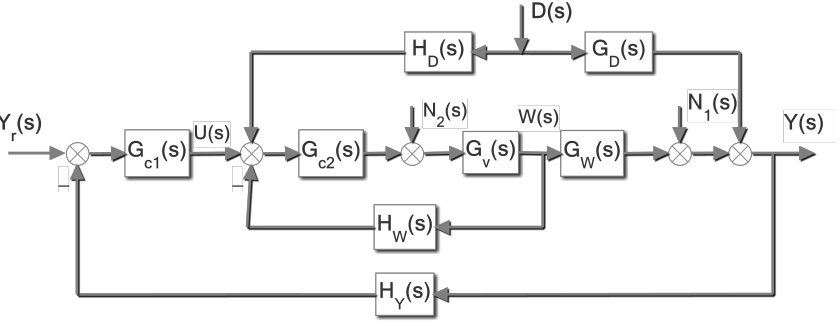
Figure 3. Transfer function model of drum water level system.